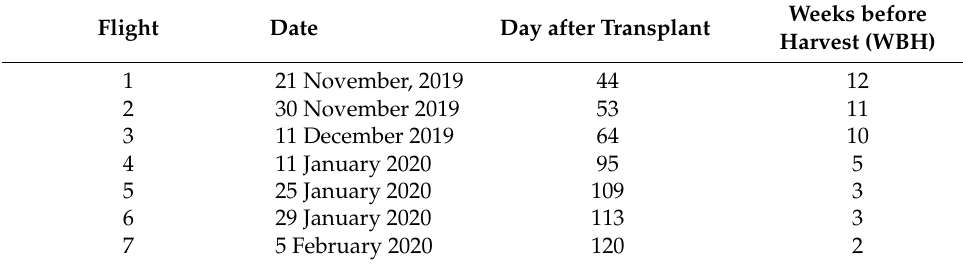
Table 2. Data collection